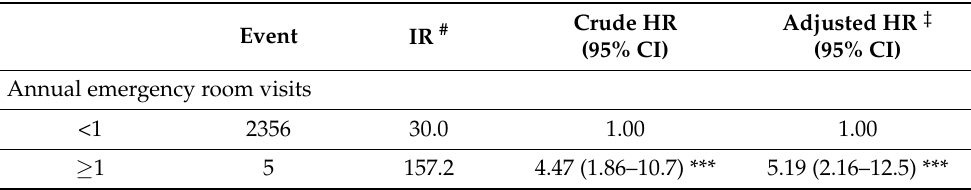
Table 4. Incidence rates and hazard ratios of periodontitis for individuals with GERD by mean number of annual emergency room